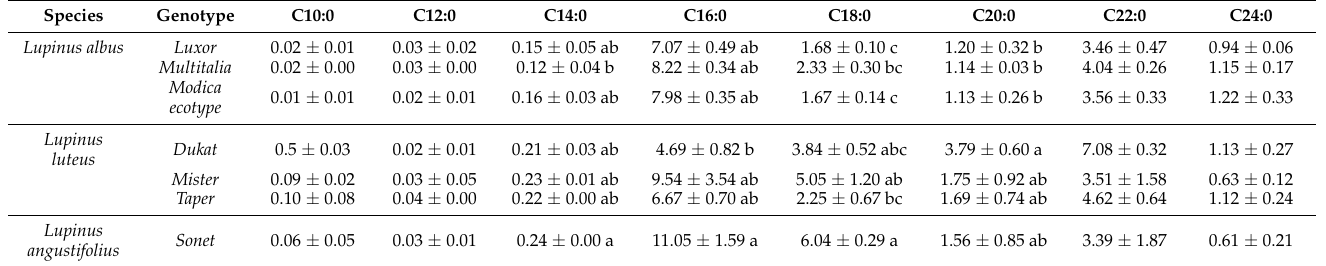
Table 4. Saturated fatty acid profiles of seed oil extracted from different Lupinus spp.